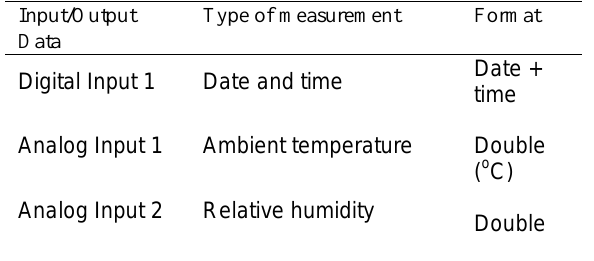
Table 1. Initial technical specification